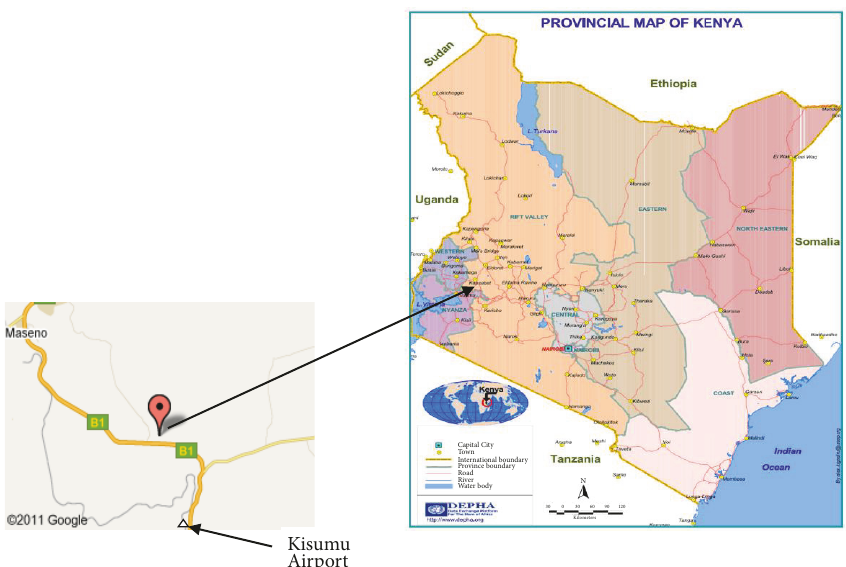
Figure 1: Study area in Kisumu, Kenya. Source: The Data Platform for the Horn of Africa (DEPHA) (www.depha.org) [12].